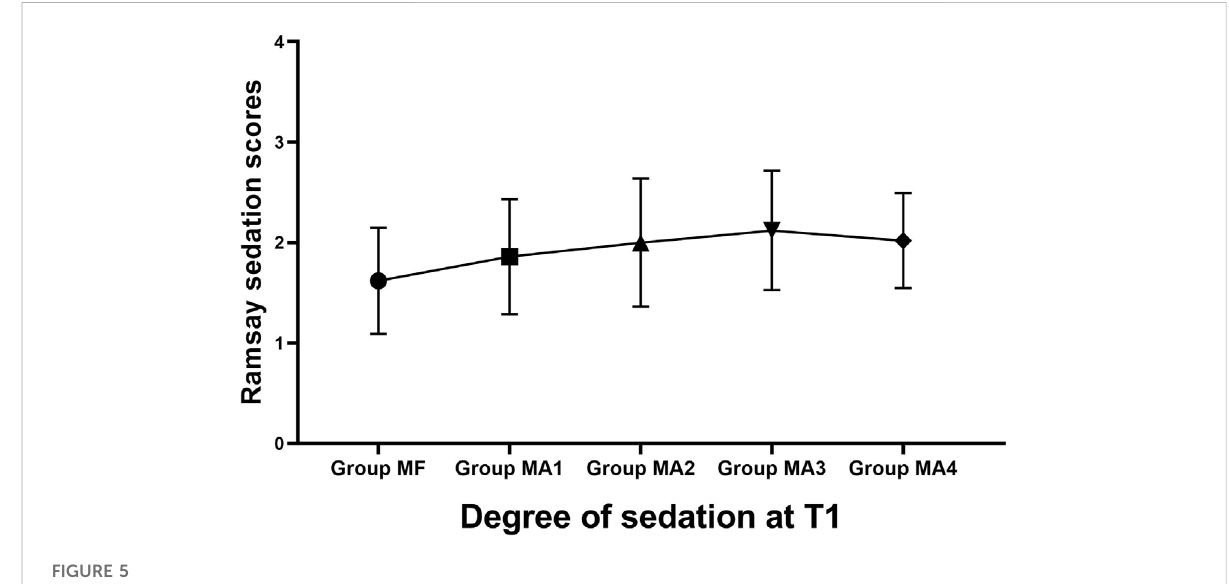
FIGURE 5 Degree of sedation at T1 in fi ve groups.